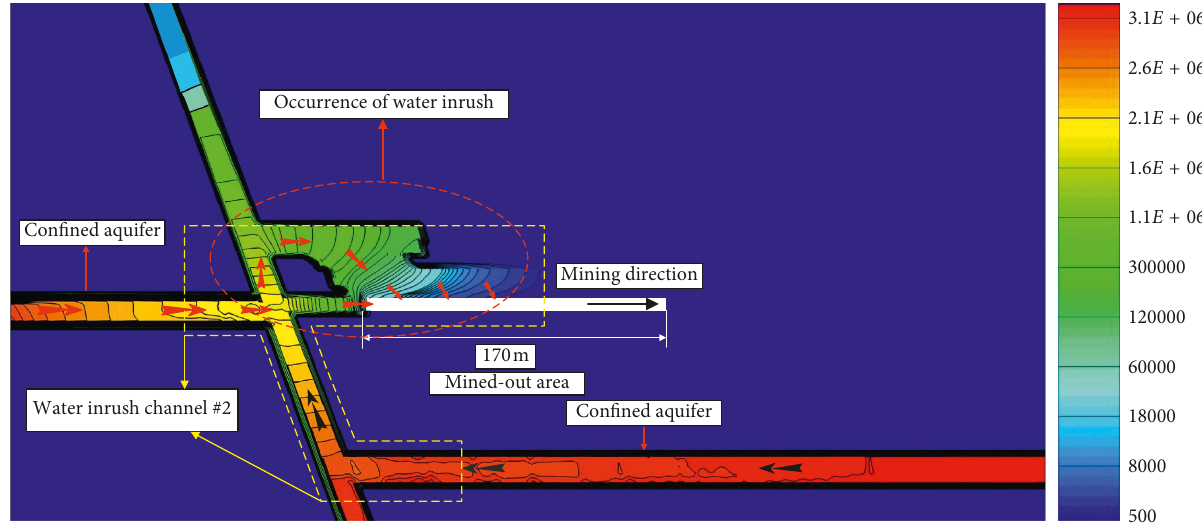
Figure 10: Pore pressure distribution when mining width reaches